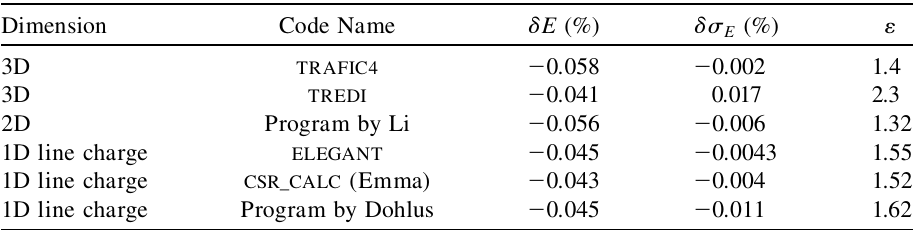
List of benchmarked codes and of the beam parameters at the end of the chicane. We have indicated with (cid:13)E the relative energy loss and with (cid:13)(cid:9) energy